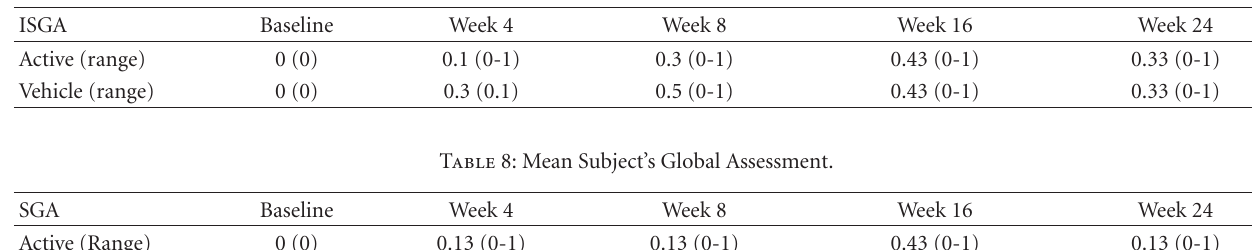
Table 7: Mean Investigator’s Static Global Assessment.